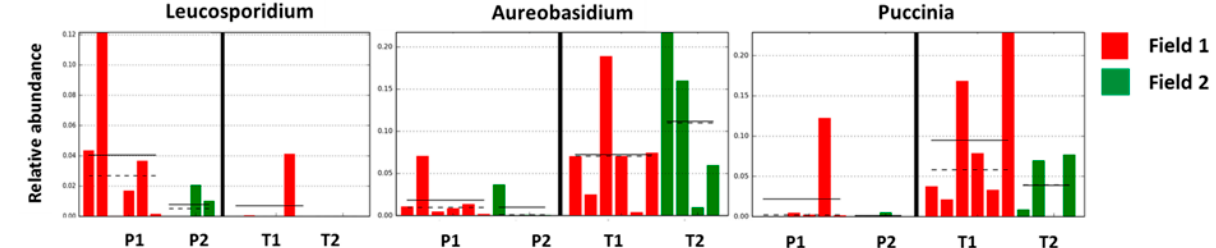
Figure 6. Discriminant fungal genera between two ancient wheat varieties. Differential genera between variety Perciasacchi (red) and Tum- minia (green), resulting from LEfSe analysis ( P < 0.05, LDA cut-off > 2). Histograms represent differential taxa distributions between the two wheat varieties and among the four sample categories: P1 = Perciasacchi from Field 1; T1 = Tumminia from Field 1; P2 = Perciasacchi from Field 2; and T2 = Tumminia from Field 2). Category means (straight line) and medians (dotted line) are